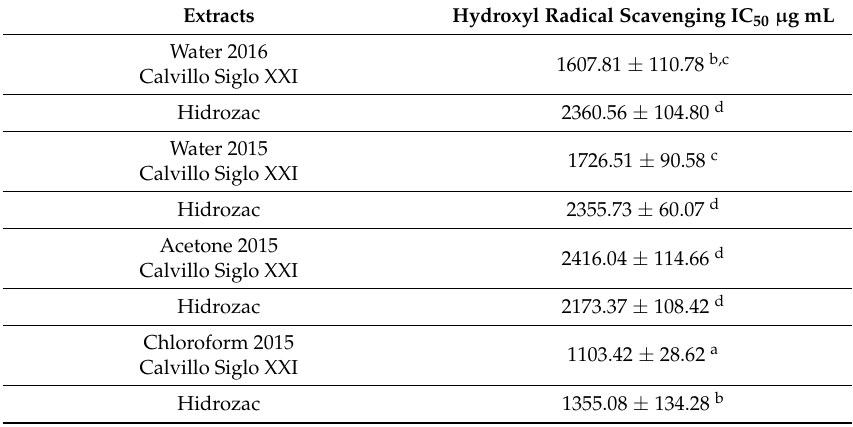
Different letters indicate significant differences ( p <